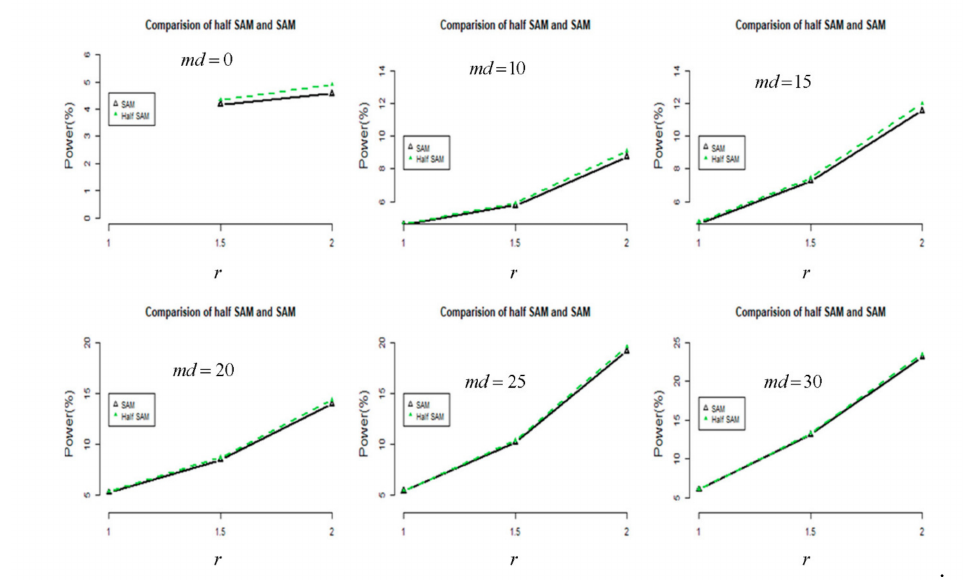
Figure 4. A comparison in terms of power (%) between half SAM and SAM using RNA-Seq data for analysis. (Black: SAM; Green: Half